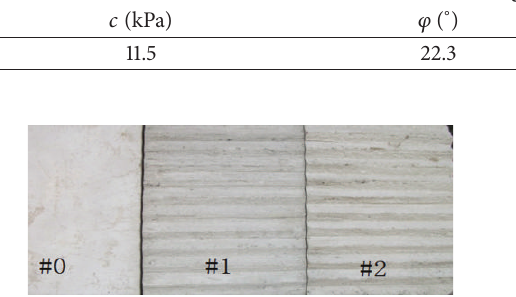
Figure 1: The topography of the concrete plate in the